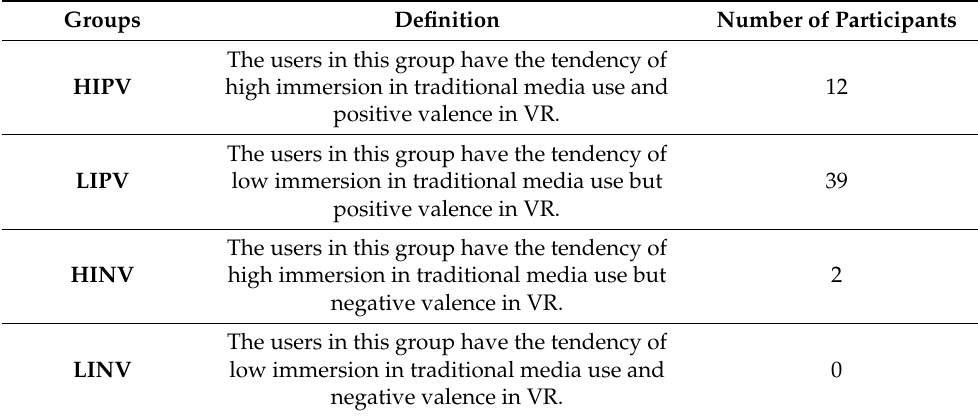
Table 3. The definition of participants groups.